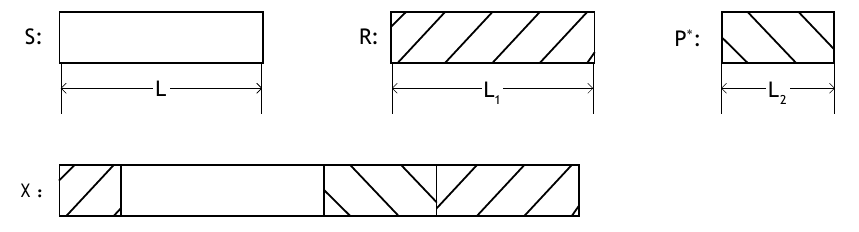
Figure 1. The generating of message X using secret S , checking sequence R and determine pointer P ∗